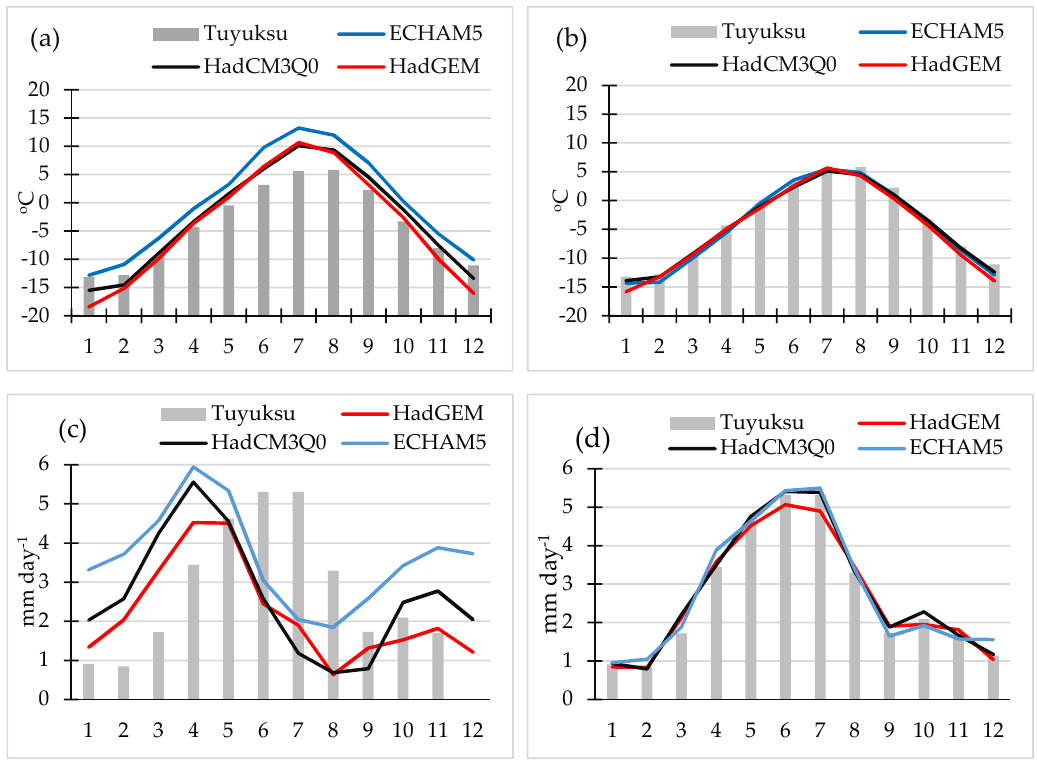
Figure 2. Observed and simulated temperature ( a , b ) and precipitation rates ( c , d ) before ( a , c ) and after ( b , d ) bias correction using the Empirical Quantile Mapping (EQM) and Delta methods for temperature and precipitation respectively for the baseline period.